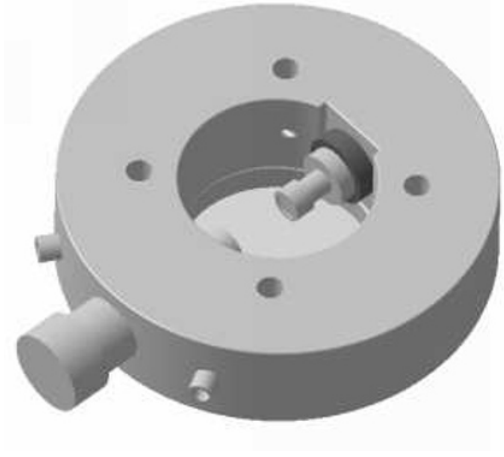
Fig. 4. Lichtarowicz cell.